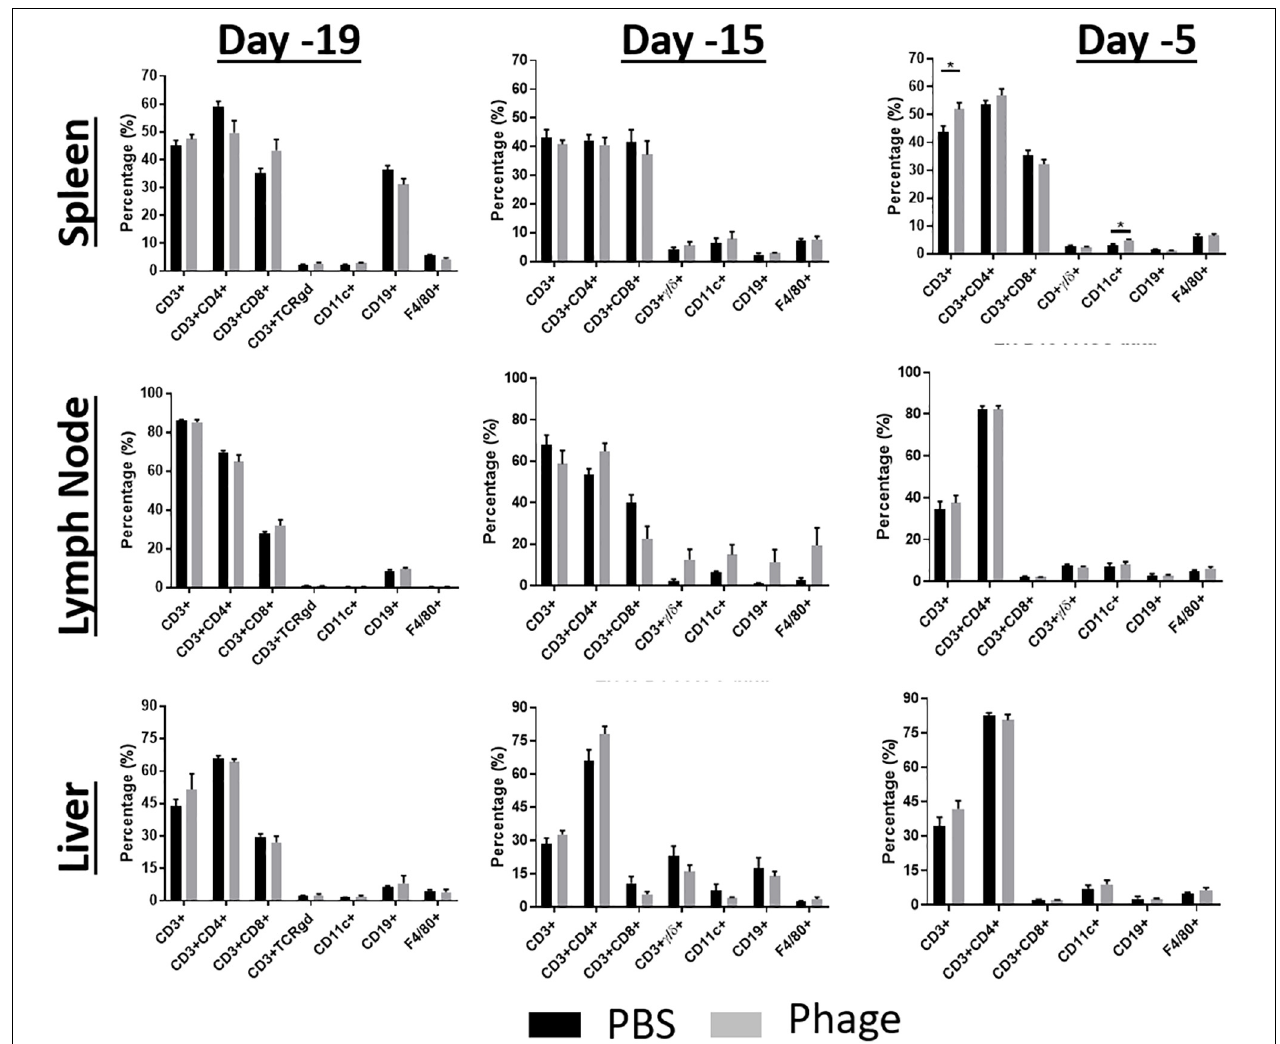
FIGURE 5 | Administration of phage mixture does not modulate immune cell populations. Immune cell populations were assessed at various time points from naïve mice following PBS (control) or phage mixture administration (i.p.). N = 6 per group per time point; * p <